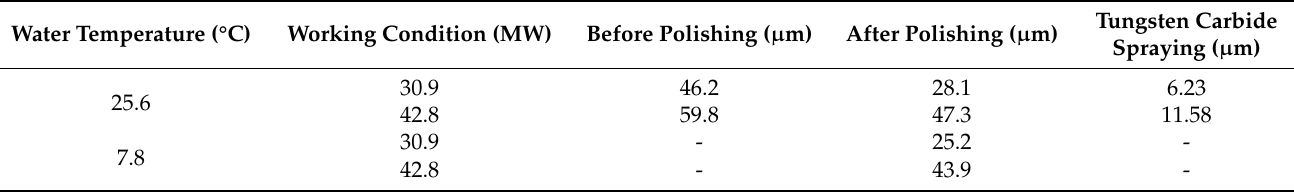
Table 6. Maximum wear under different working conditions.